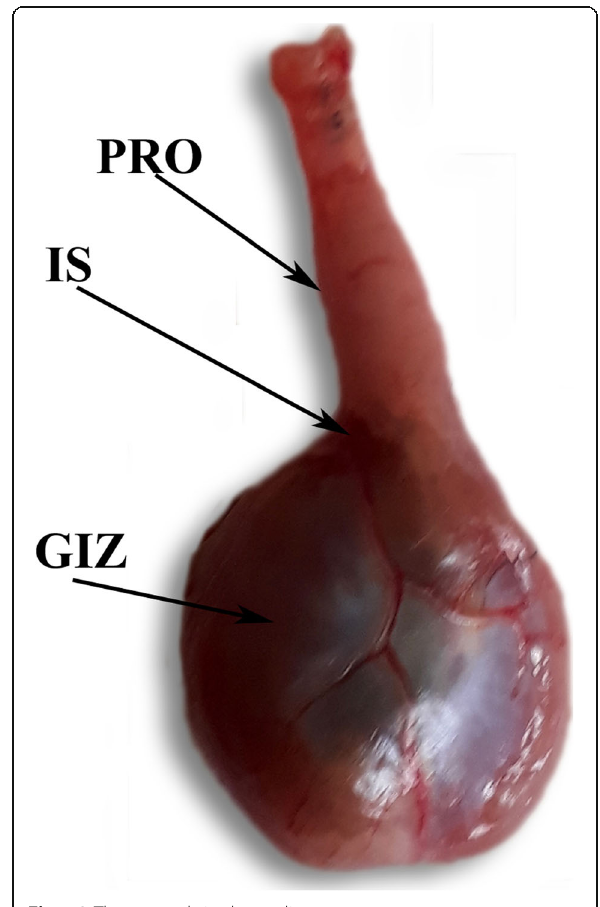
While the gizzard appeared as a solid muscular struc- ture in both birds, in the zebra finch, the gizzard has a disc or circular shape and is pink in color, and the con- tact area of the duodenum with the gizzard is close to the glandular gastric region of the gizzard from the ven- tral side of the gizzard, and their walls have a high blood supply and a diameter of 1 ± 0.05 cm (Figs. 1 and